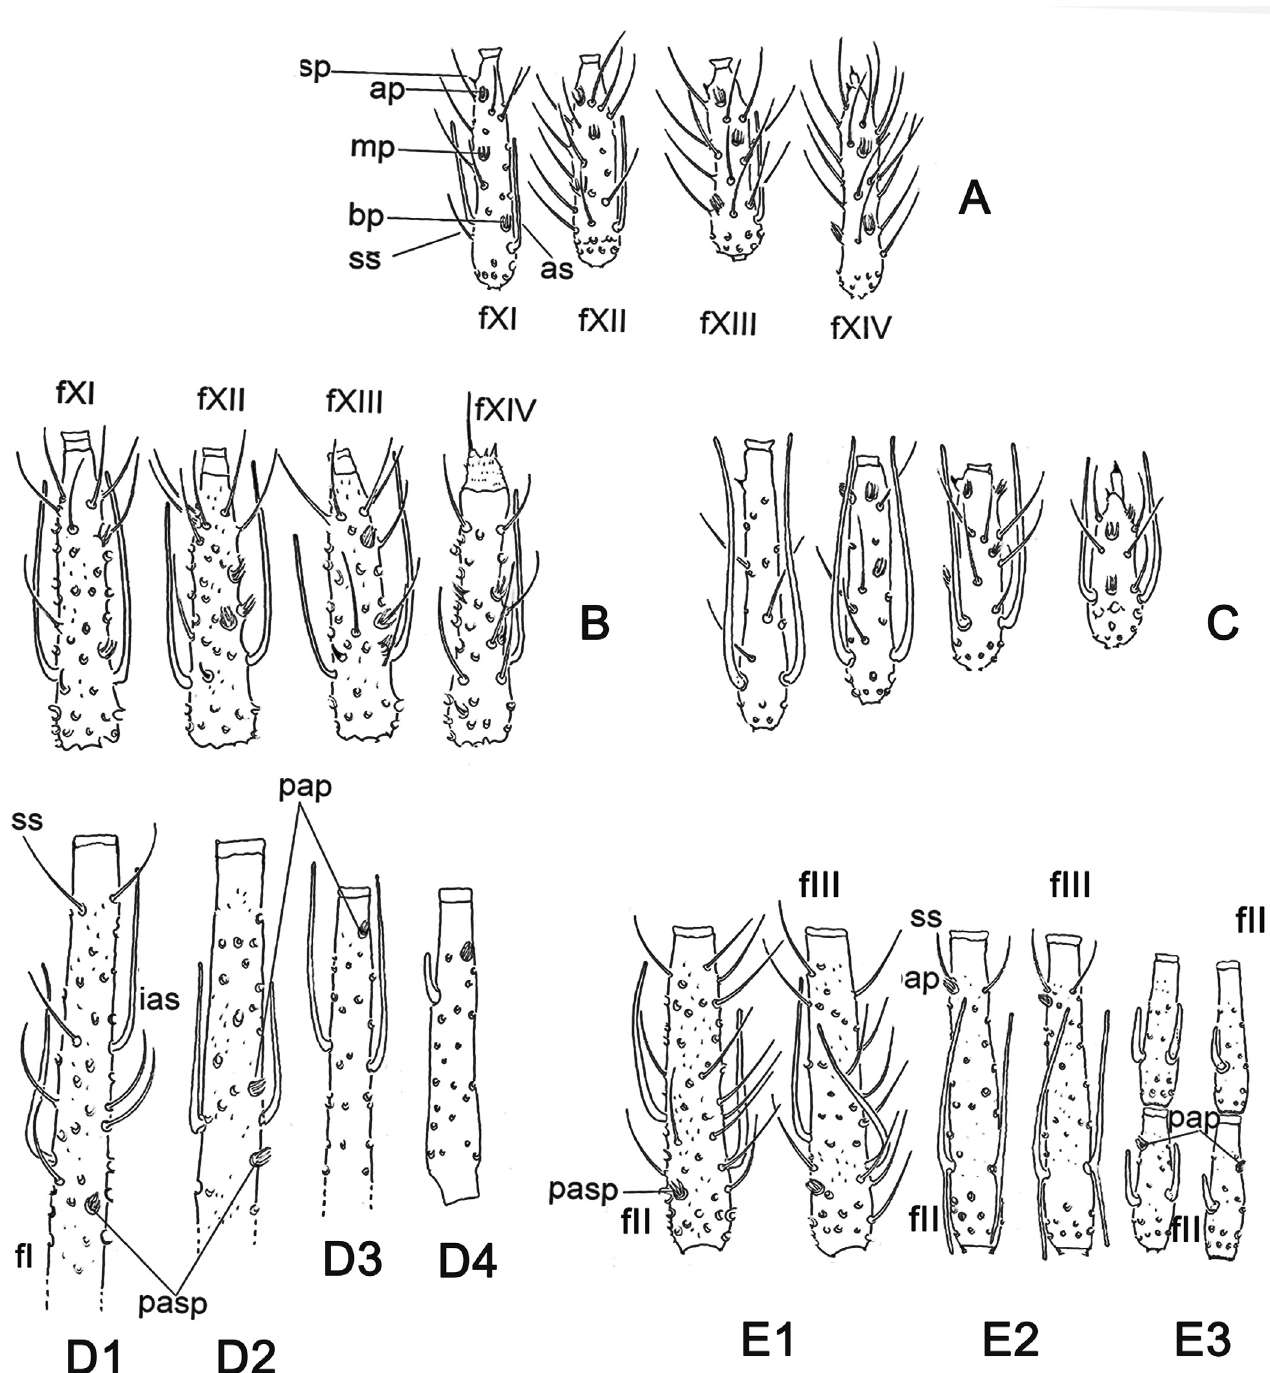
Figure 4. Aspects on the presence and distribution of ascoids, papillae, and simple setae on flagellomeres of Phlebotominae: (A–C) apical flagellomeres (fXI–fXIV): (A) Evandromyia ( Barrettomyia ) tupynambai ( # ); (B) Warileya rotundipennis ( $ ); (C) Trichophoromyia ubiquitalis ( $ ). (D1–D4) First flagellomere (fI) of phlebotomine: (D1) Warileya rotundipennis ( $ ); (D2) Psychodopygus squamiventris ( $ ); (D3) Evandromyia aroucki ( # ); (D4) Sergentomyia dubia ( # ). (E1–E4) 2nd and 3rd flagellomeres of phlebotomines: (E1) Warileya rotundipennis ( $ ); (E2) Psathyromyia shannoni ( $ ); (E3) Sergentomyia dubia ( $ ); (E4) Sergentomyia dubia ( # ). ap – Apical papilla; as – ascoid; bp – basal papilla; ias – internal ascoid; mp – median papilla; p – papilla; pap – preapical papilla; pasp – preascoidal papilla; sp – spiniform papilla; ss – simple